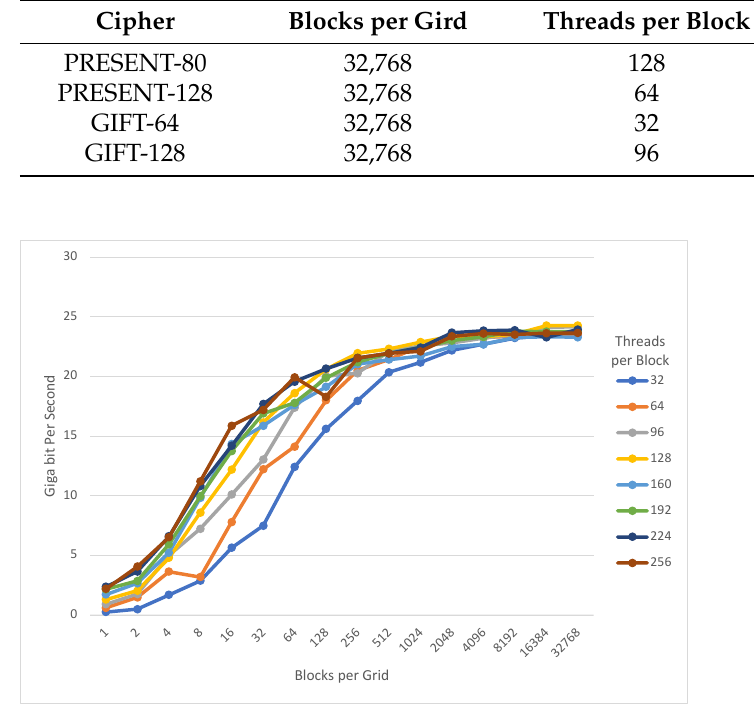
Figure 8. PRESENT-80 encryption: Comparison of the number of encryption per second.